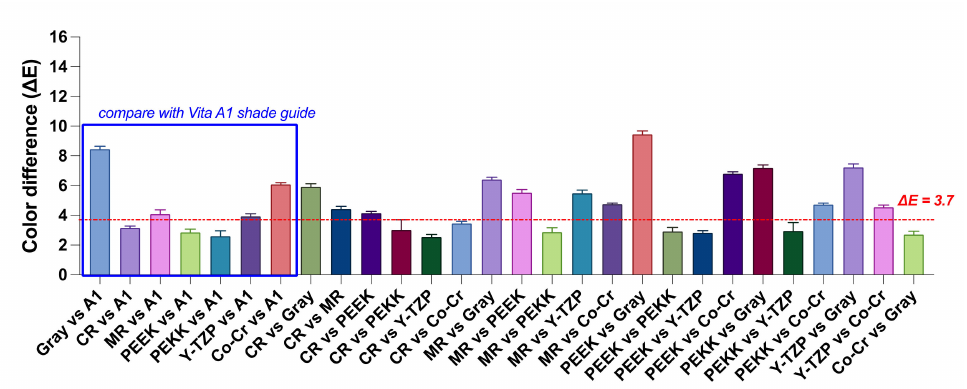
Figure 3. Pairwise comparison of the color difference ( ∆ E) of M-Zr samples measured under different substrates. Blue box represented the ∆ E compared with the Vita A1 Shade guide (L* = 76.7, a*= 1.1, and b* = 14.7). Horizontal dotted line represents clinical indicators of ∆ E = 3.7